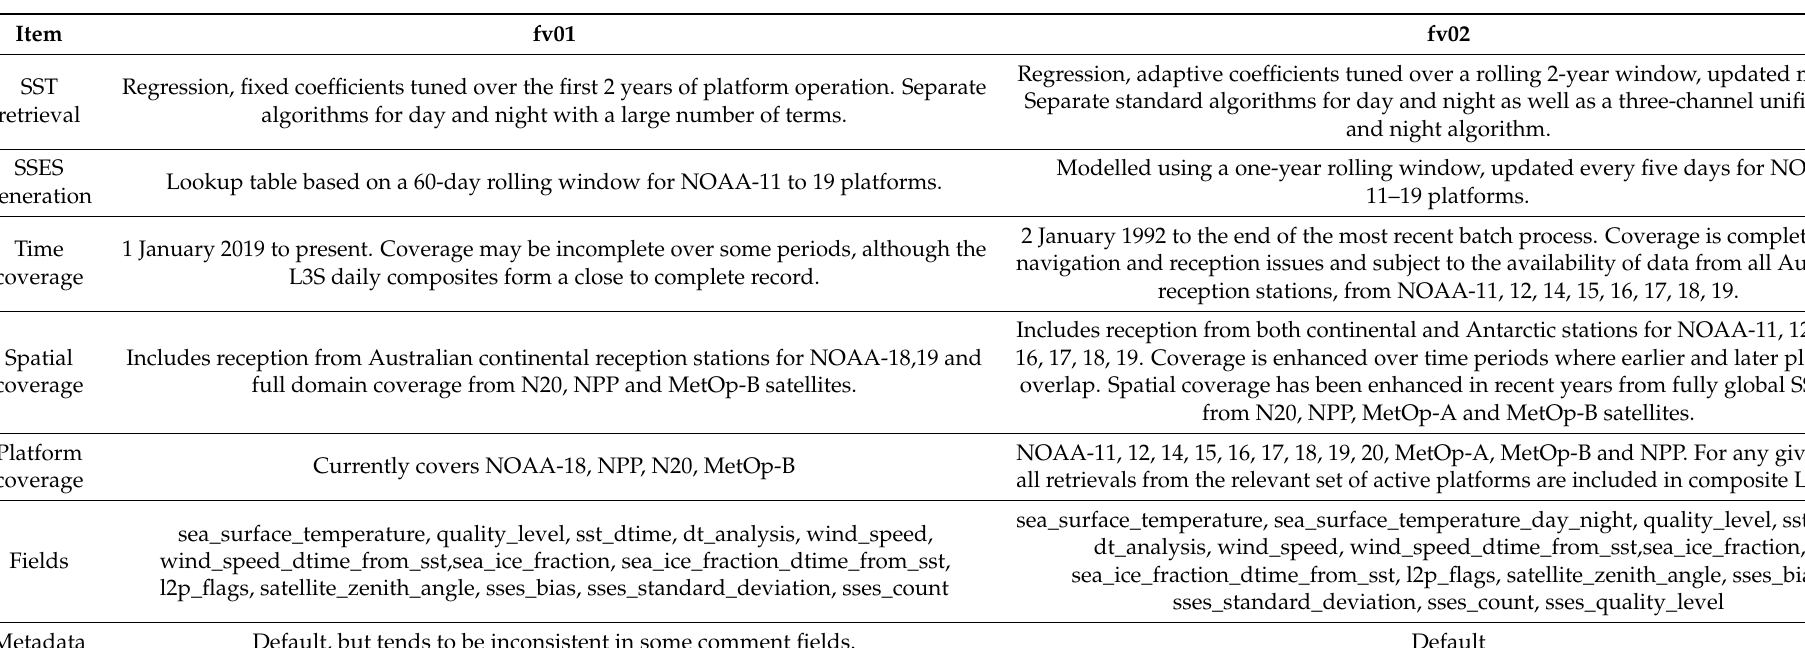
Table 1. Difference between fv01 and fv02 SST product